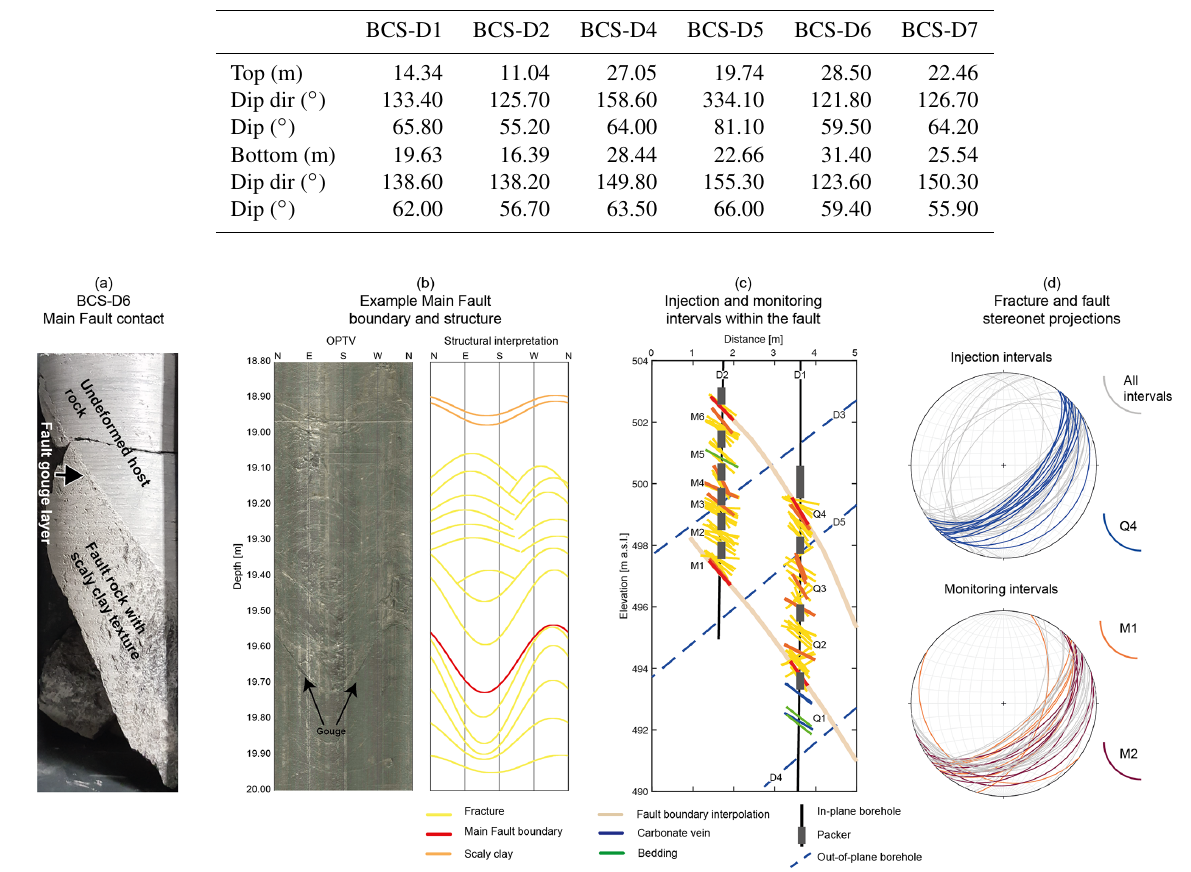
Figure 8. (a) An example image log of the contact between the main fault and the host rock is shown. (b) An example of the contact between the host rock and the main fault from the core. (c) Injection and monitoring intervals and mapped structures within the main fault boundaries. (d) Fracture and fault stereonet projections within the injection borehole (top) and monitoring borehole (bottom). The stereonets highlight all the structures within the main fault (grey) and the structures from the injection interval Q4 (blue), monitoring interval M1 (orange), and monitoring interval M2